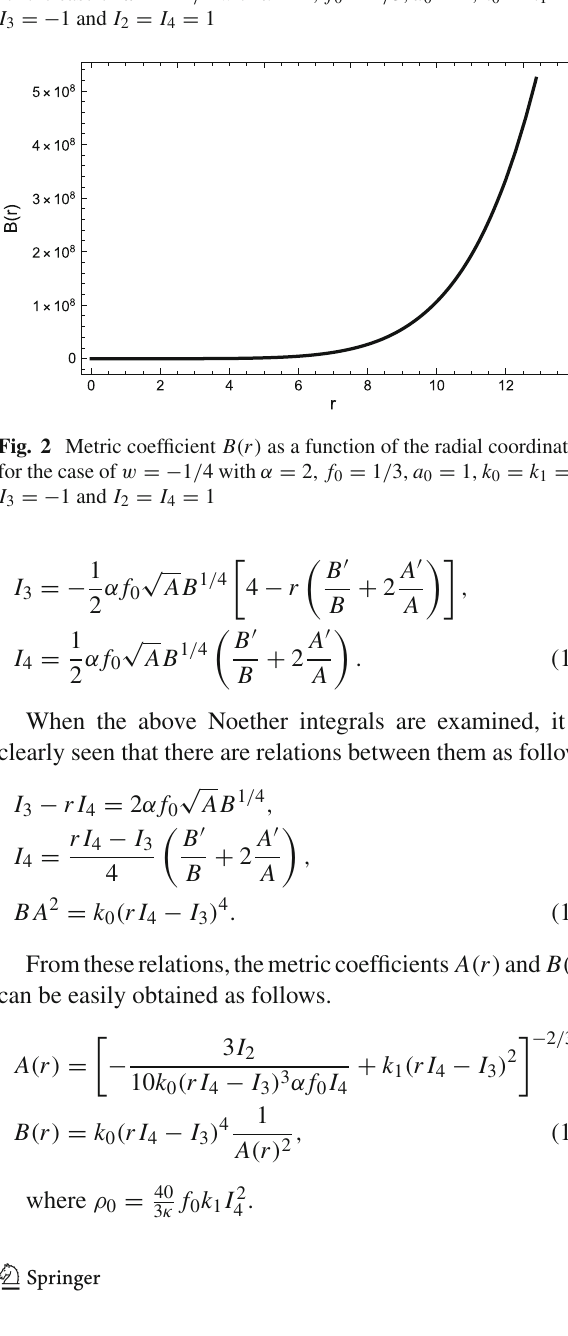
Fig. 1 Metric coefficient A ( r ) as a function of the radial coordinate r for the case of w = − 1 / 4 with α = 2, f 0 = 1 / 3, a 0 = 1, k 0 = k 1 = 1,